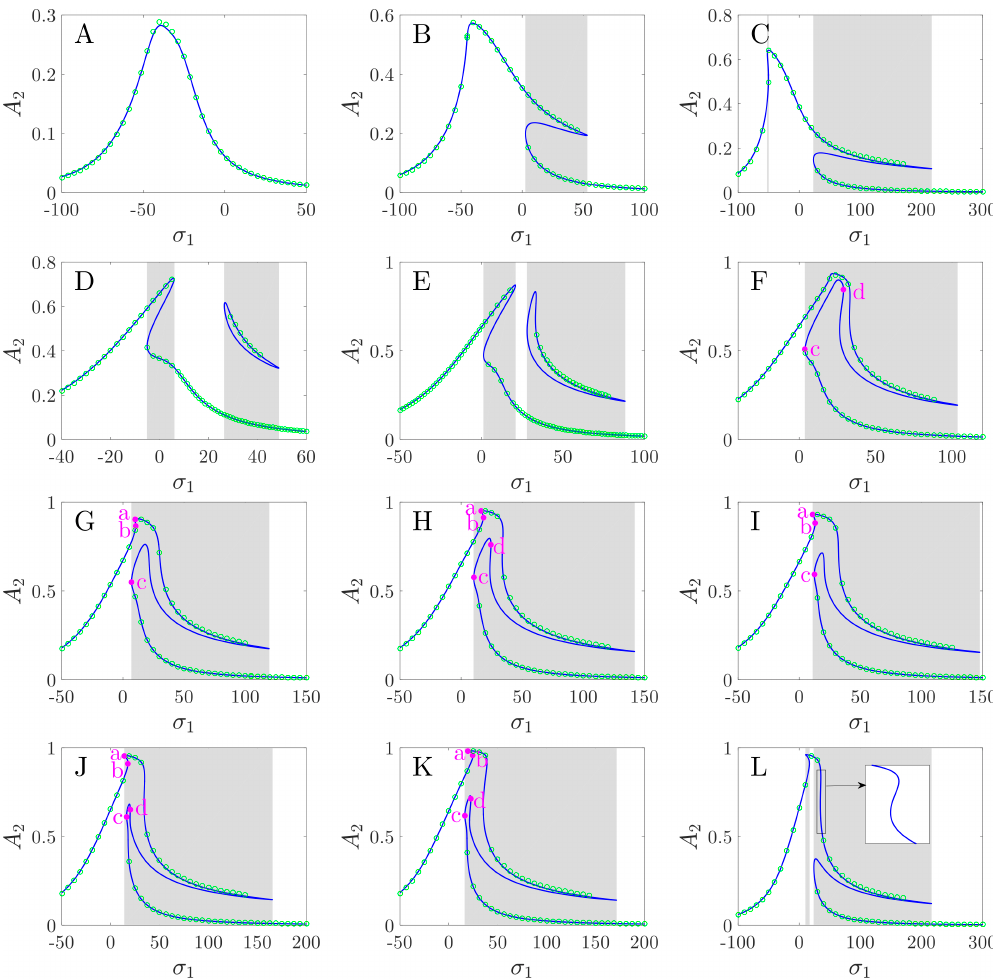
Figure 9. Bifurcation diagrams of the detecting amplitude variation with detuning parameters corresponding to different regions of Figure 8. The shaded areas denote the multi-solution areas, and the green circles denote the numerical